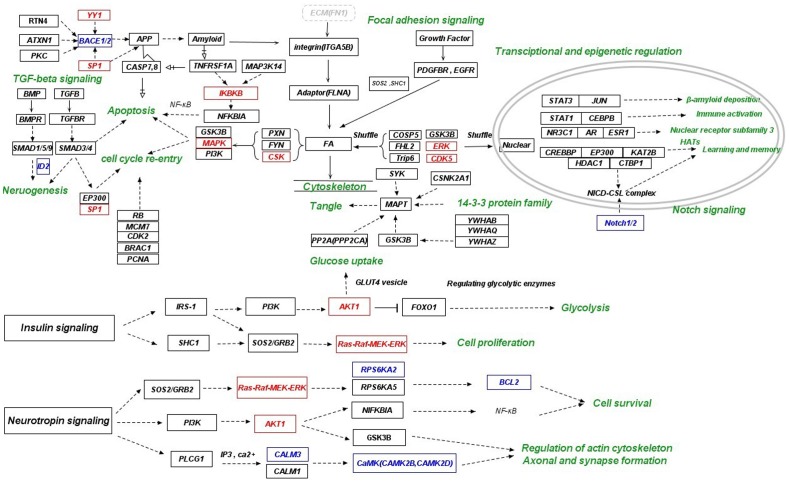
Mechanistic illustration of the adaptation strategy reflected in the hub network via manual integration of literature and KEGG pathways (part 2).The “healthy” neurons respond to the AD-specific microenvironment through alteration of survival signaling. Relevant functional categories for survival signaling include focal adhesion signaling, insulin and neurotrophin signaling, TGFB signaling, apoptosis (TNF-receptor signaling), cell cycle re-entry and genes related to amyloid and NFT formation. Hub genes are indicated by black color. Closely related non-hub genes in the perturbed subnetwork are indicated by blue color. Transcription factors and kinases whose targets or substrates were enriched in the subnetwork are indicated with red color. (other thanSP1 and YY1, these genes are also hub genes). Cellular functions are indicated by green color.